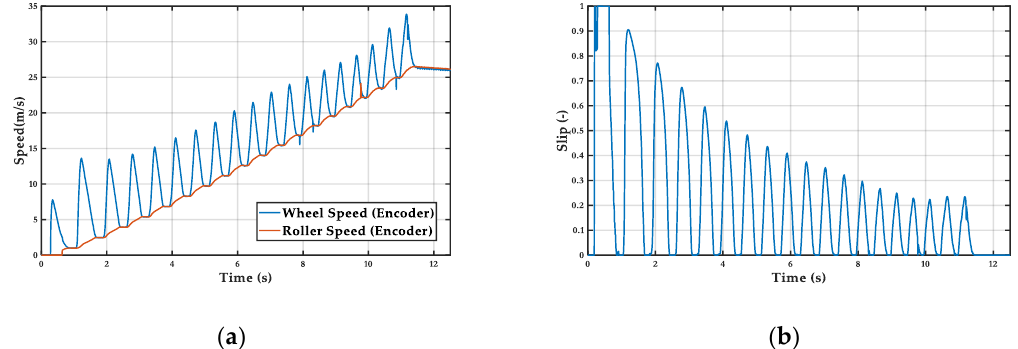
Figure 9. Relay controller: ( a ) wheel and roller speed, ( b ) wheel slip.